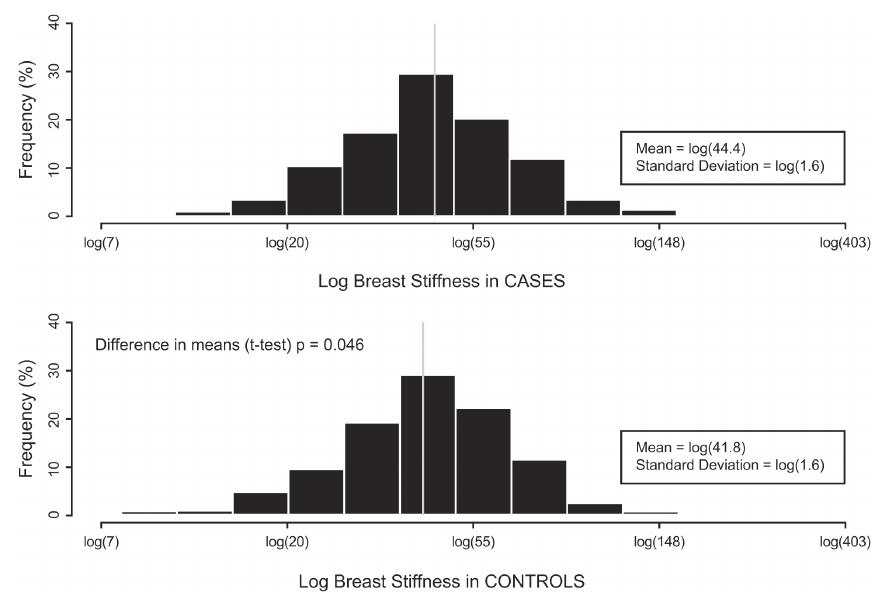
Figure 2. Histograms of the distributions of the stiffness measures in cases and controls. The stiffness measures were natural logarithm transformed. In each plot, the thin vertical line represents the mean of the distribution.